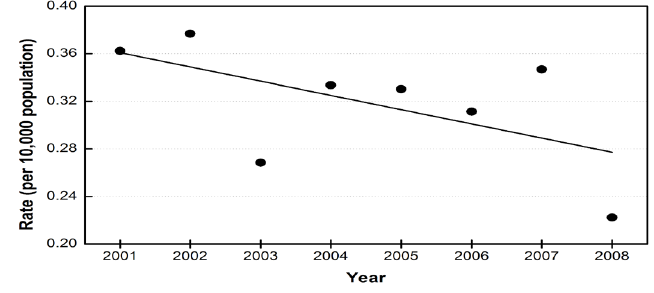
Figure. Rates of eye injuries due to motor vehicle crashes treated in United States emergency